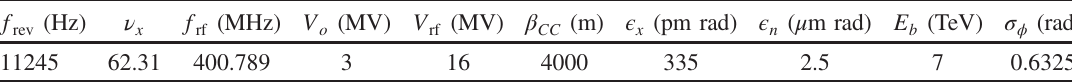
TABLE I. HiLumi LHC parameters.